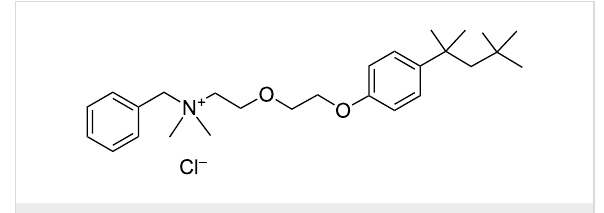
Figure 9: Chemical structure of benzethonium chloride.